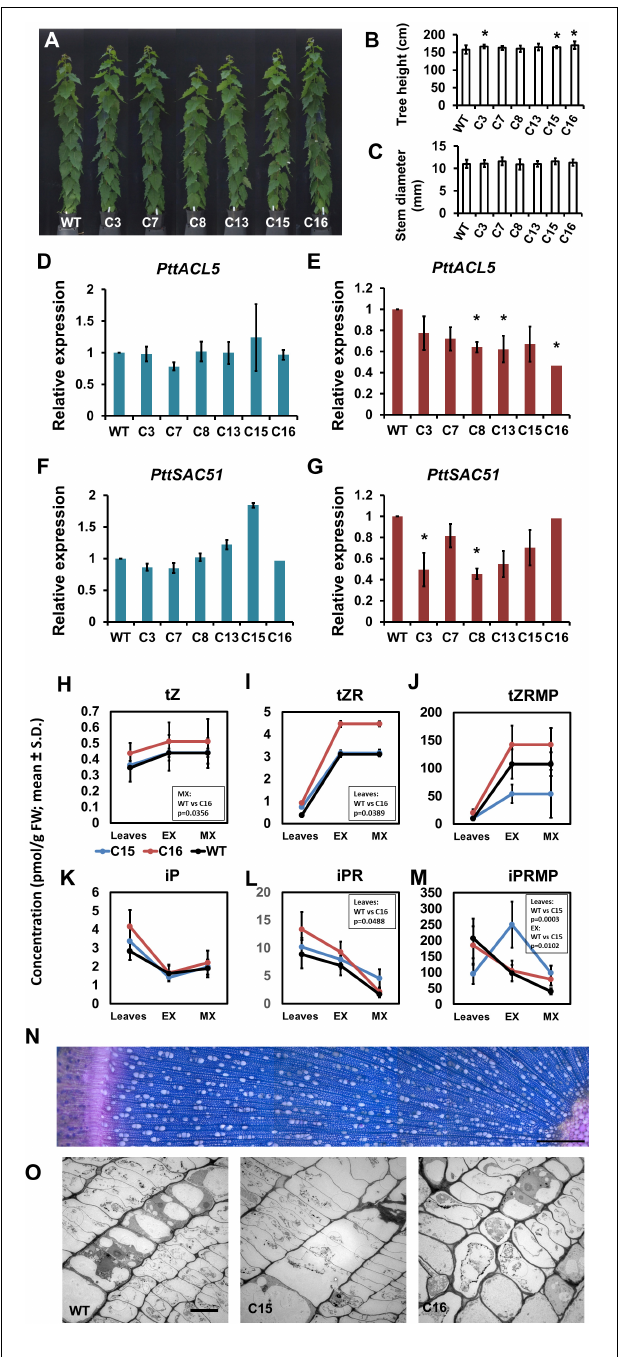
FIGURE 5 | Phenotypic characterization of transgenic trees expressing p COMT:PttACL5 . Overall growth (A) , tree height (B) and stem diameter (C) is shown for 2-month-old trees of transgenic lines C3, C7, C8, C13, C15, and C16. (D–G) Gene expression analysis in secondary xylem tissues of greenhouse grown p COMT : PttACL5 trees. Mean values ± SD of expression is shown for PttACL5 (D,E) and PttSAC51 (F,G) in expanding xylem (D,F) and in maturing xylem tissues (E,G) relative to the wild type. (H–M) . Concentration of cytokinins in wild type (WT) and p COMT:PttACL5 lines C15 and C16. Mean values for three biological replicates ± SD are shown for trans -zeatin ( t Z; H ), trans -zeatin riboside ( t ZR; I ) and trans -zeatin